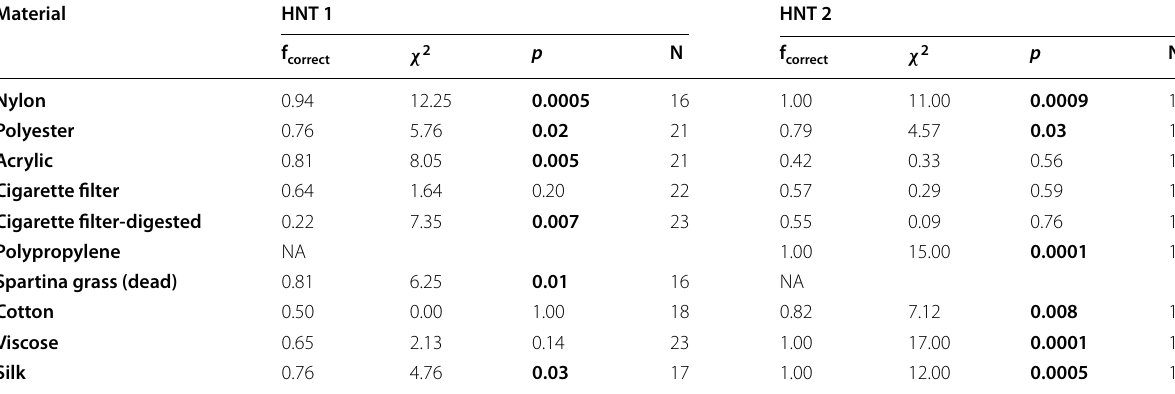
Table 4 Chi-square goodness of fit test whether the proportion of correct or incorrect fiber tests is significantly different than